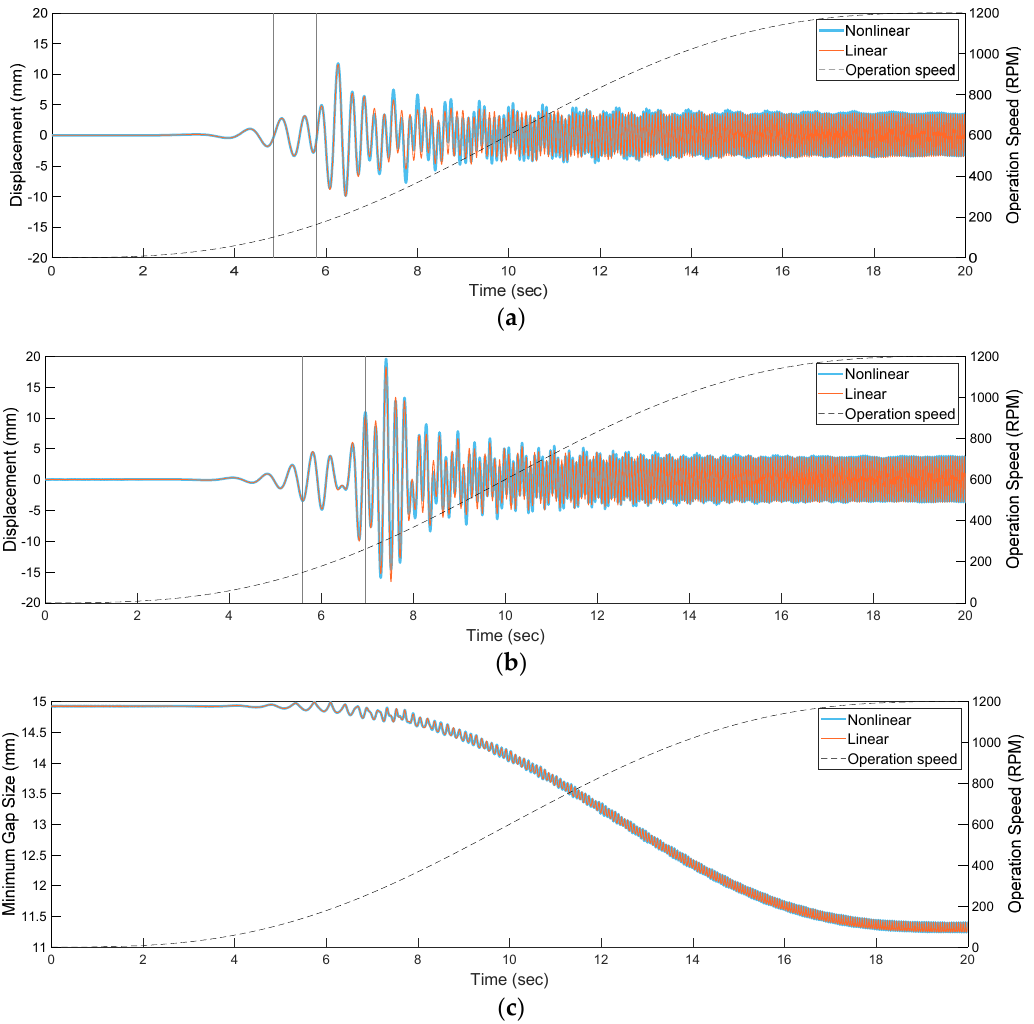
Figure 9. Comparison of transient responses obtained with the nonlinear and linear analytical models: ( a ) tub front center horizontal displacement, ( b ) tub front center vertical displacement, and ( c ) minimum gap size between the tub and drum.